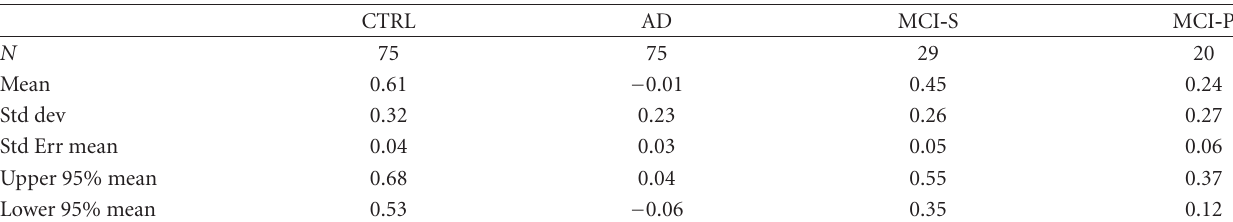
Table 3: Morphological factor